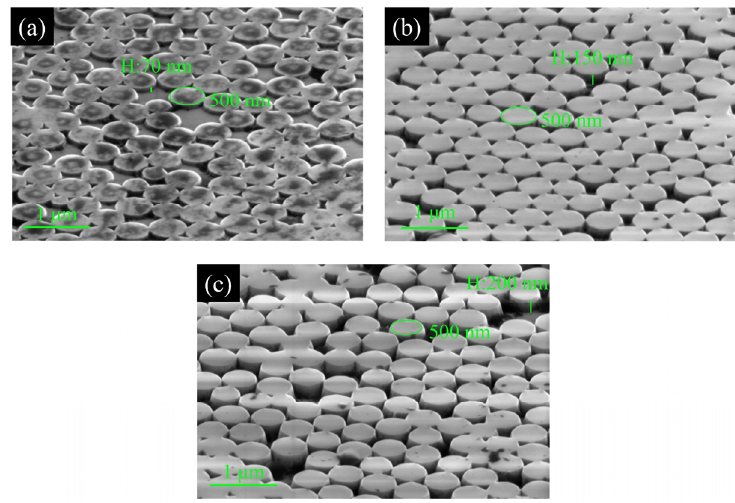
Figure 4. SEM image of ( a ) etched 70 nm sample, ( b ) etched 150 nm sample, and ( c ) etched 200 nm sample.